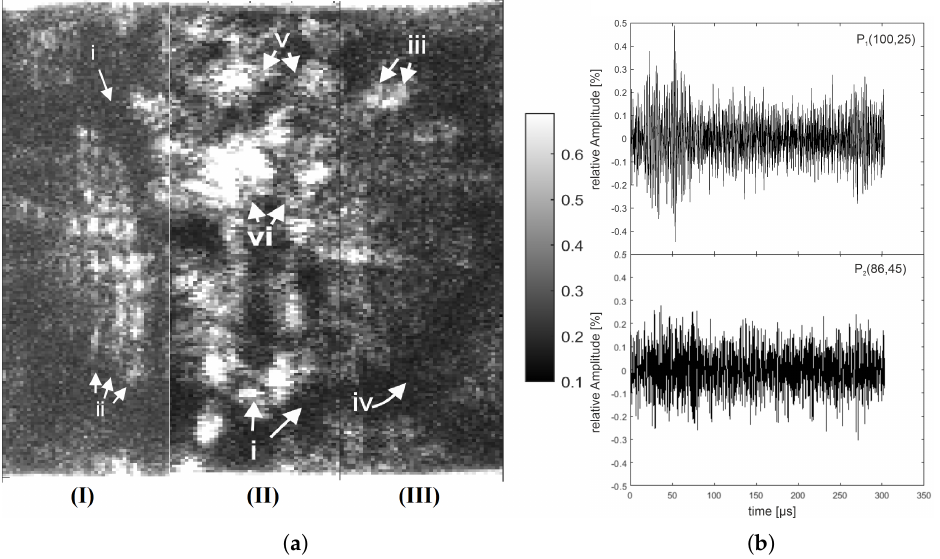
Figure 5. Air-UT result: ( a ) amplitude image of the three scanned sections (I, II, and III) and ( b ) comparison of A-signals of two arbitrary points in section I with high and low signal-to-noise